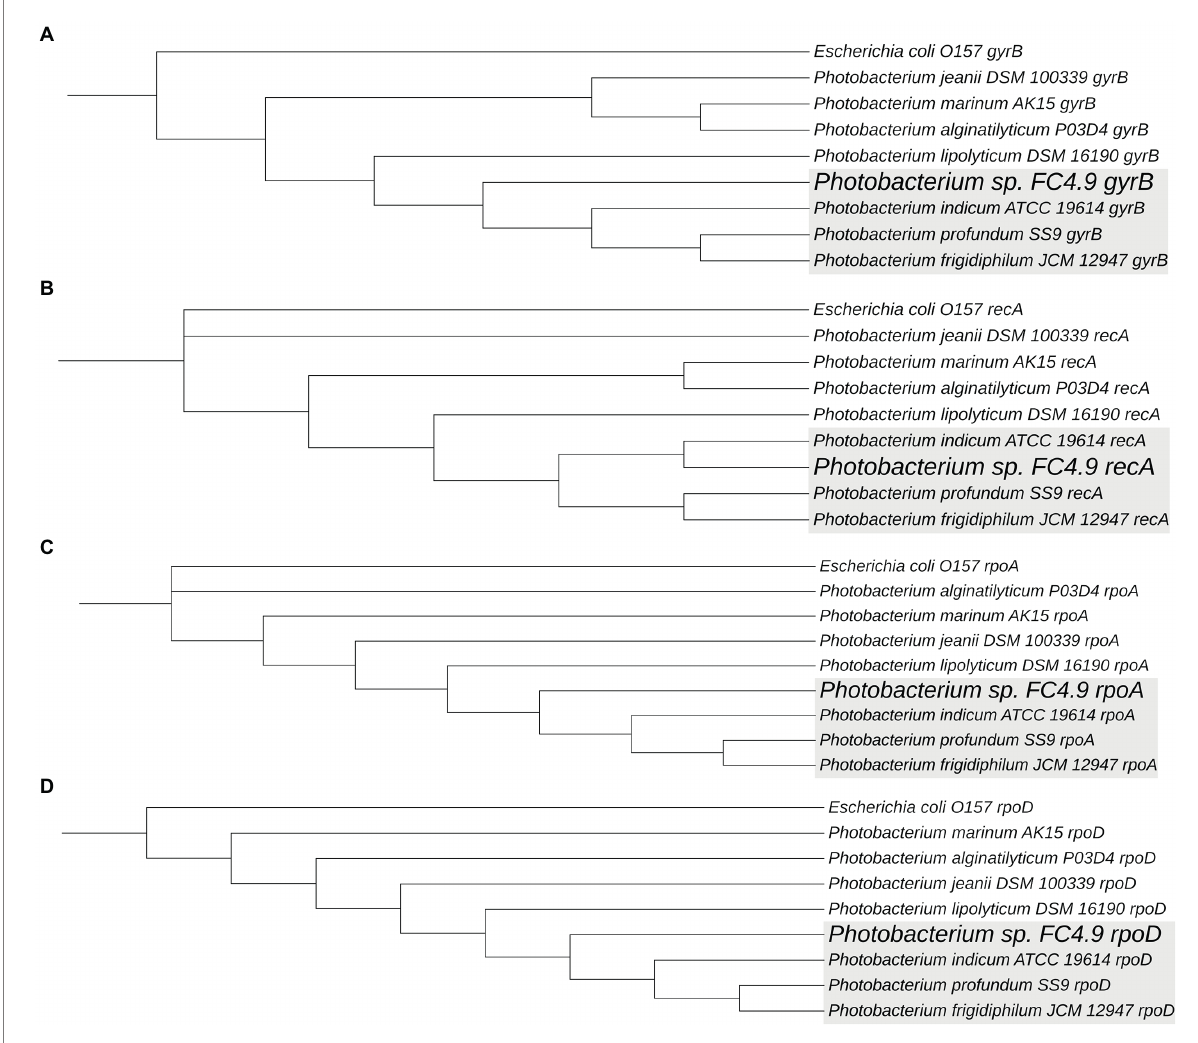
FIGURE 4 Photobacterium sp. FC4.9 was shown to be closely related to P. indicum , P. profundum and P. frigidiphilum . Phylogenetic trees were generated from multiple sequence alignments of Photobacterium sp. FC4.9 genes gyrB (A) , recA (B) , rpoA (C) and rpoD (D) , obtained from whole genome sequences, against the 7 Type Species within the Profundum clade of the genus. All trees were routed to respective gene sequences from Escherichia coli